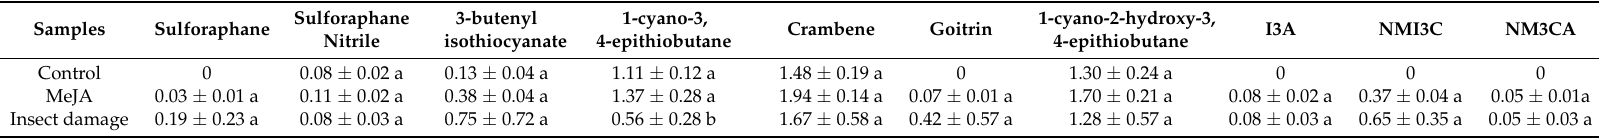
Table 2. Glucosinolate hydrolysis profiles ( µ mol · g − 1 DW) of “Red Russian” control kale and kale plants treated with 250 µ M methyl jasmonate (MeJA) or infested with T. ni for 4 days z